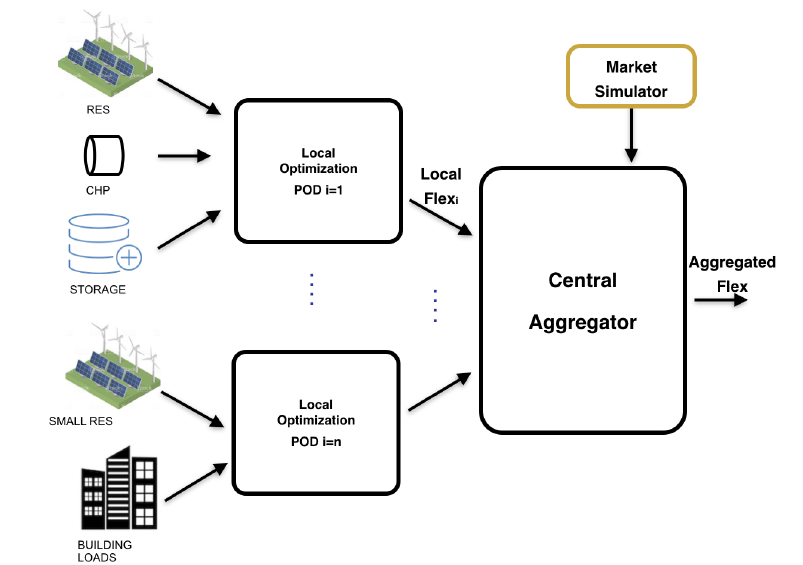
Figure 6. Different Levels of